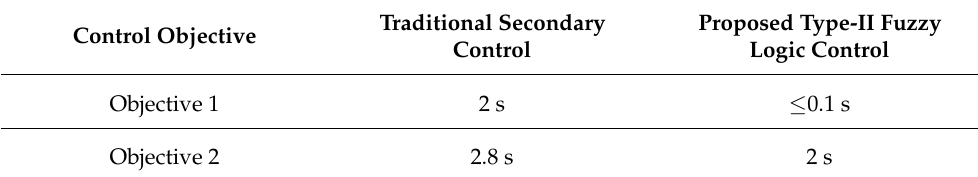
Table 3. Proposed scheme with other control